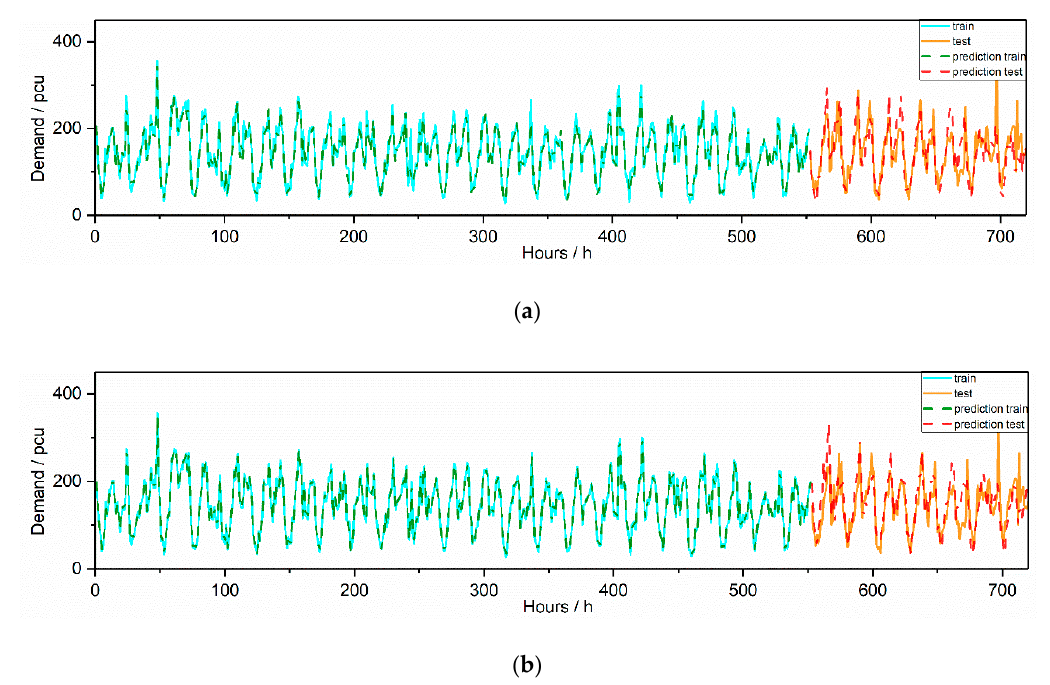
Figure 8. Average RMSE of online taxi-hailing demand prediction based on BPNN and XGB in different hours. ( a ) RMSE of the prediction models based on BPNN; ( b ) RMSE of the prediction models based on XGB.